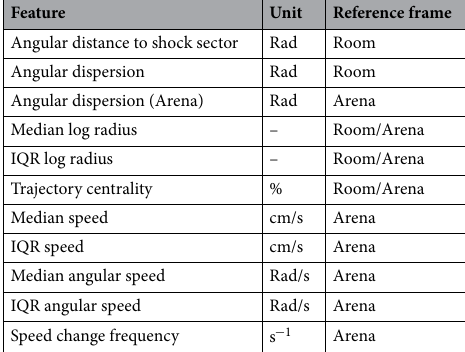
Table 2. Features for the data clustering of trajectory segments. For a detailed description please refer to the Materials and Methods Section.